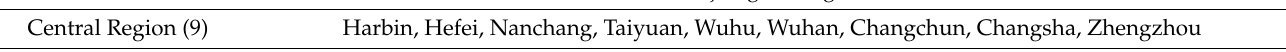
Table 1. Research sample and regional distributions. Region Cities of DZs